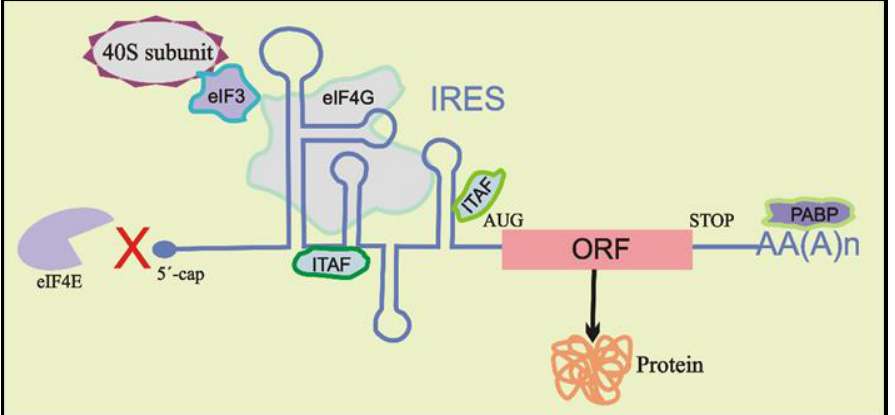
Figure 2. Schematic representation of cap-independent translation. Stem–loop secondary structures within the IRES in 5’ UTR may recruit the 40S ribosomal subunit directly to the start codon (AUG) of the open reading frame (ORF) or its vicinity through direct or indirect interactions, requiring the aid of certain canonical initiation factors (eIFs) and/or IRES trans-acting factors